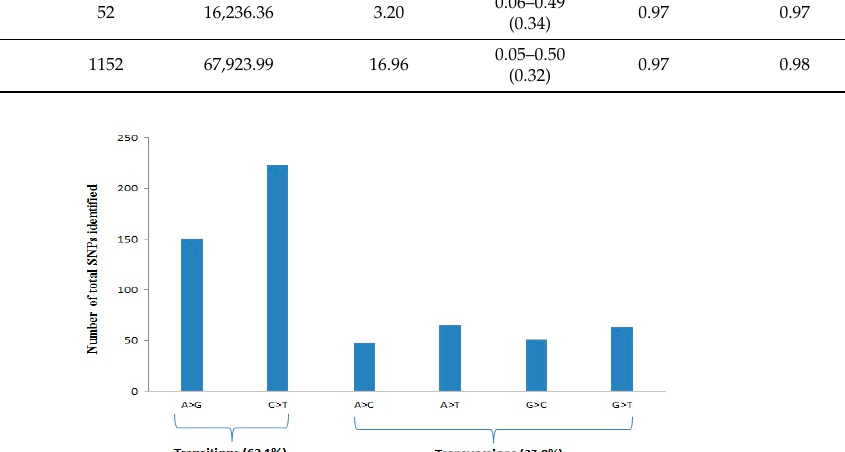
Figure 1. Percentage distribution of transition and transversion SNPs identified using DArTseq assay. Distribution of heterozygous chickpea genotypes and SNP markers revealed low values of heterozygosity (>0.2) in more than 75% of chickpea genotypes and SNP markers (Figure 2). These observations are to be expected since chickpea is a highly self-pollinated crop. Functional annotation of 1152 SNP variants showed the total of SNPs in genes was 917 (79.6%), of which (545) 59.4% were in exons. A total of 6669 functional effects for SNP variants were predicted for 1152 SNPs. The predicted effects were of modifier type (88.38%), moderate impact (3.72%), low impact (7.38%), and high impact (0.53%).